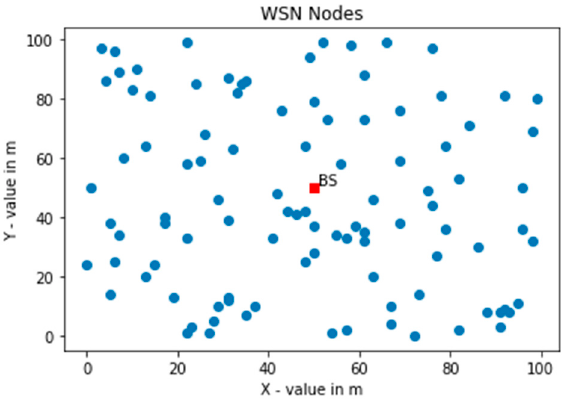
Figure 6. Random deployment of 100 sensor nodes in an area of 100 m × 100 m with BS positioned inside the deployment area.